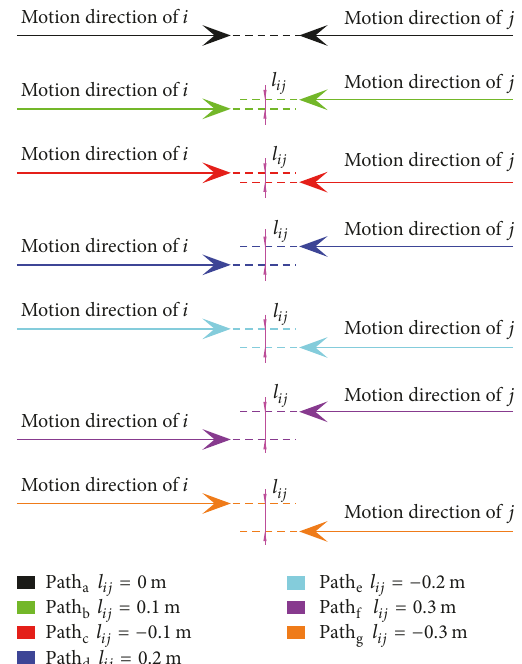
Figure 2: The different relative positions. We use the vertical 𝑙 𝑖𝑗 (from the center of pedestrian 𝑗 to the movement direction of pedestrian 𝑖 ) to reflect the relative position of pedestrians 𝑖 and 𝑗 .